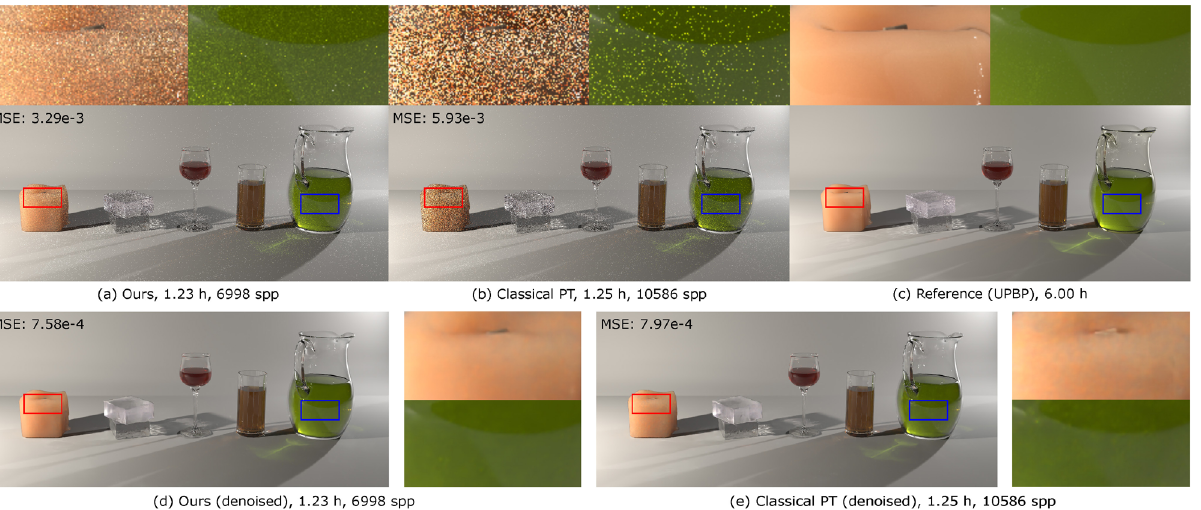
Fig. 13 Comparison of our method and path tracing with equal time for the Still Life